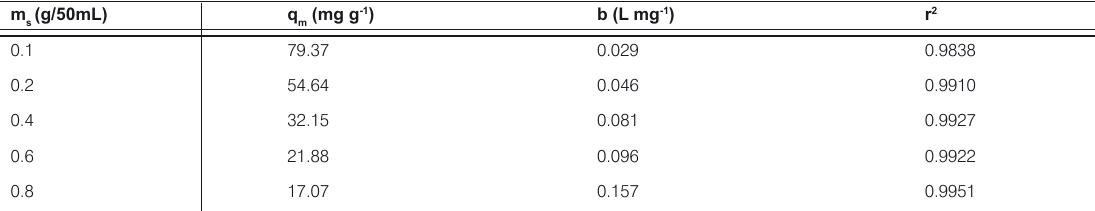
Figure 2. Linear plot of the value of q Table 2. Langmuir isotherm constants for CR at various PKC dosages m s